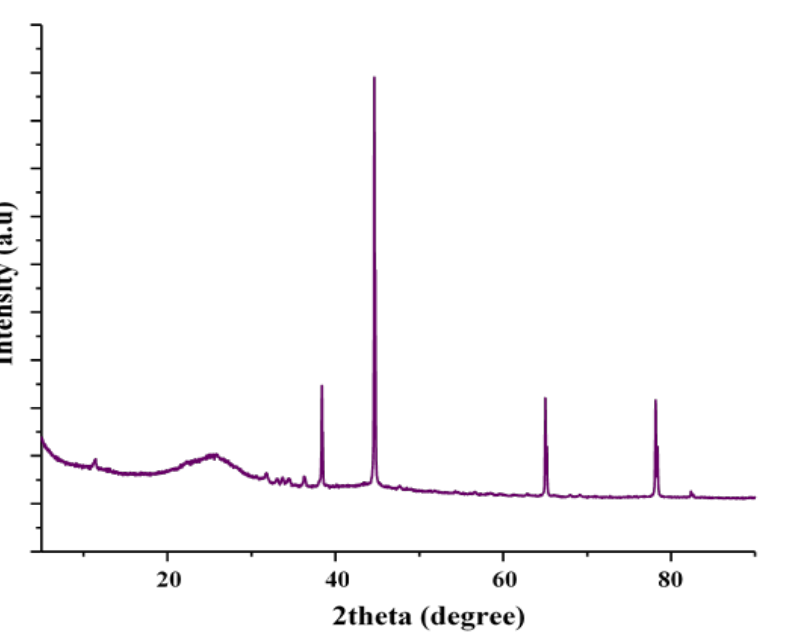
Figure 2. XRD pattern of MSMPAC.